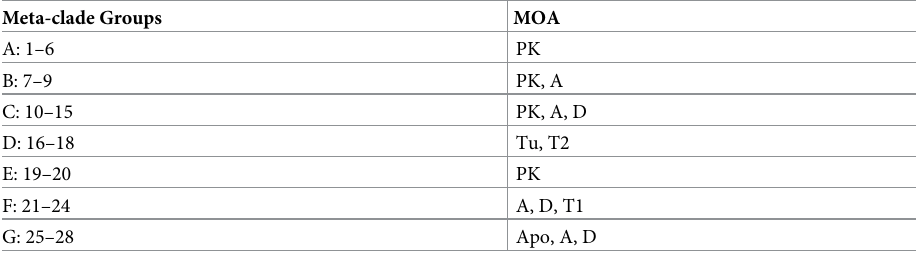
Table 1. Most frequent primary MOA assignments within meta-clade groups A:G. Meta-clade